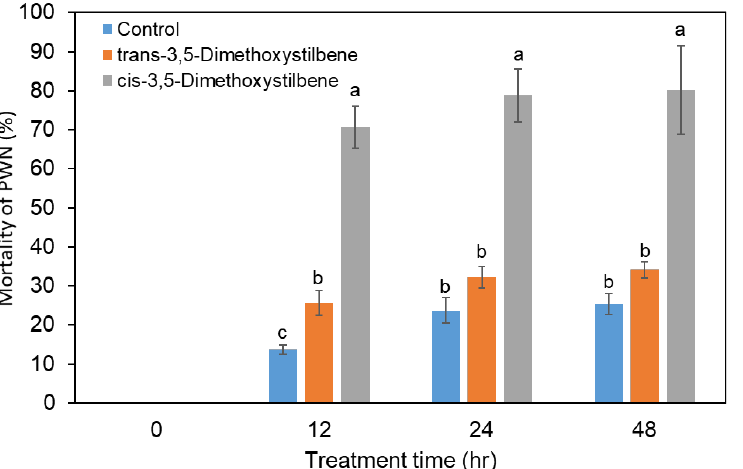
Figure 6. Nematicidal activity of trans -3,5-dimethoxystilbene and cis -3,5-dimethoxystilbene against Bursaphelenchus xylophilus during 48 h of treatment. Experiment was repeated in triplicate. Error bars indicate the standard error of the mean (±SE) of three replicate measurements. Different letters above the bars indicate significantly different values ( p < 0.05), calculated using one-way ANOVA followed by Duncan’s post hoc analysis.